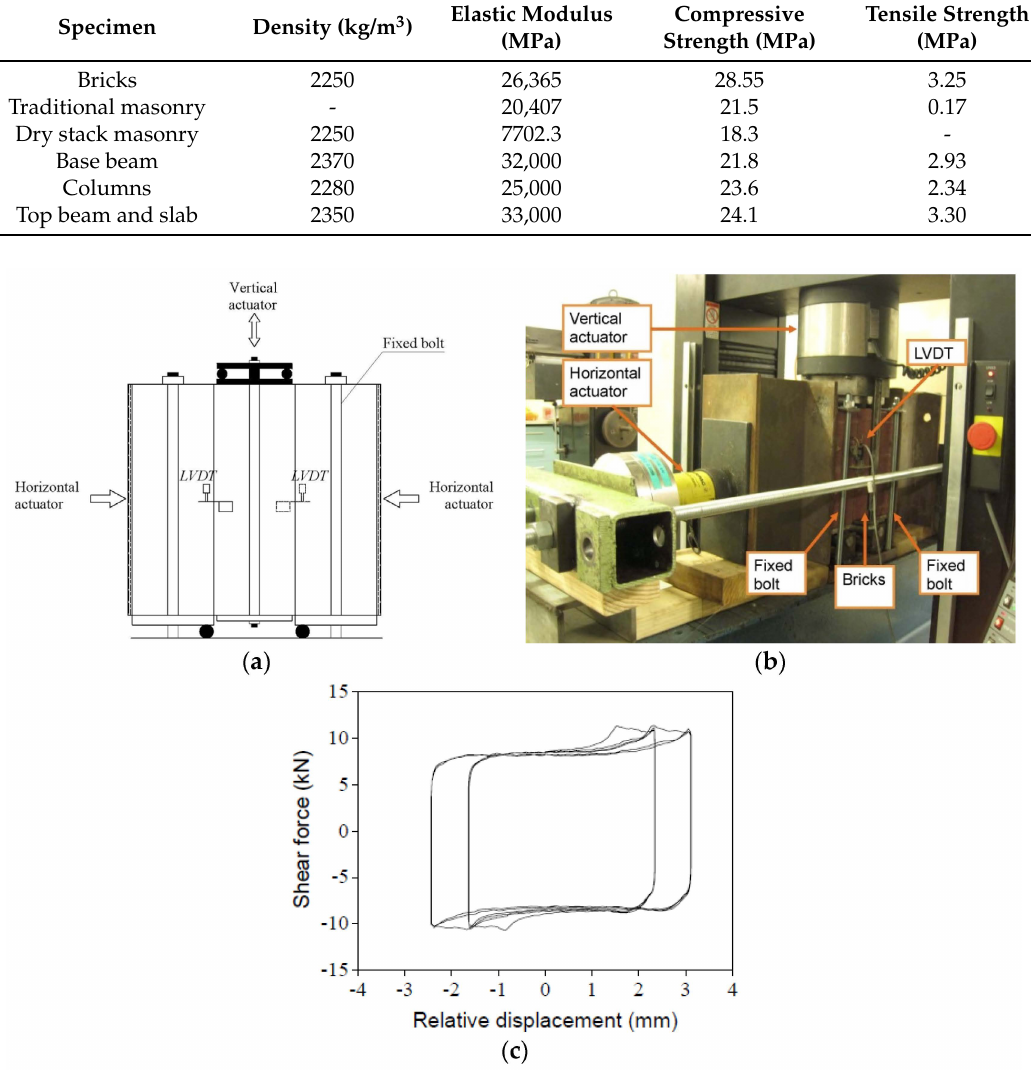
Figure 3. Compression-shear test of dry stacked masonry triplets: ( a ) Schematic diagram of the test; ( b ) Test setup; ( c ) Typical test result. LVDT, linear variable displacement